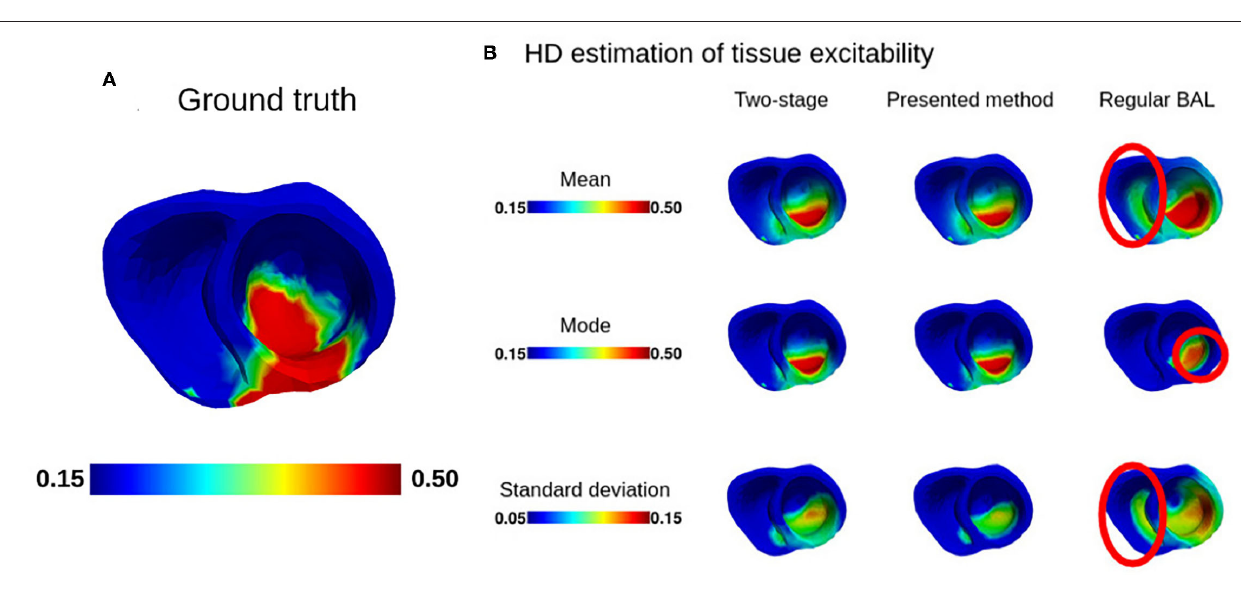
FIGURE 5 | (A) The ground truth of tissue excitability. (B) Mean, mode, and standard deviation of tissue excitability estimated from presented